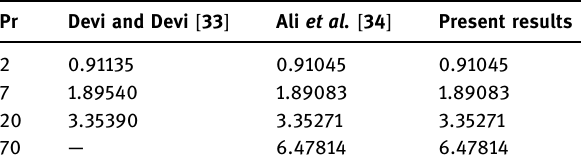
Table 3: Change in heat transfer for di ff erent Prandtl